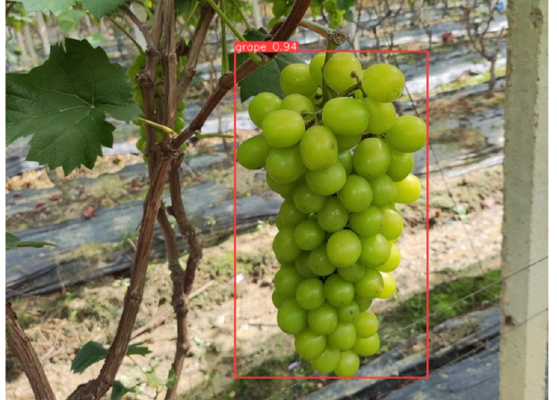
Figure 9. Target